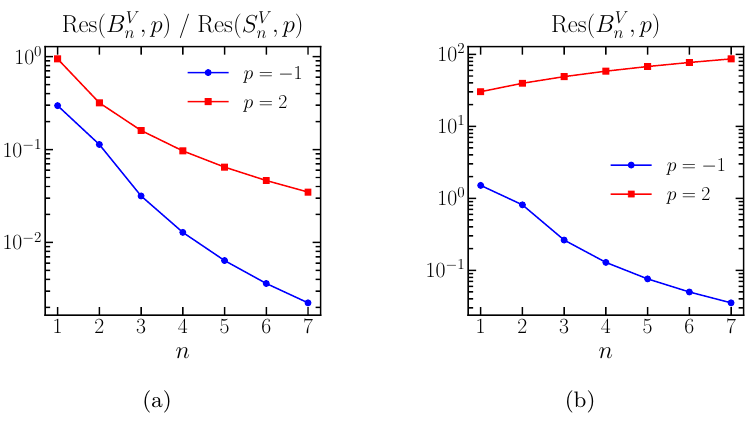
relative to those of S V for the leading UV and n n for the same n